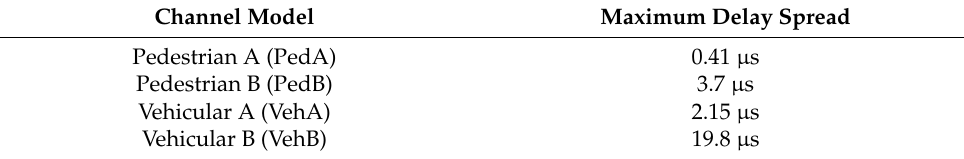
Table 3. Channel